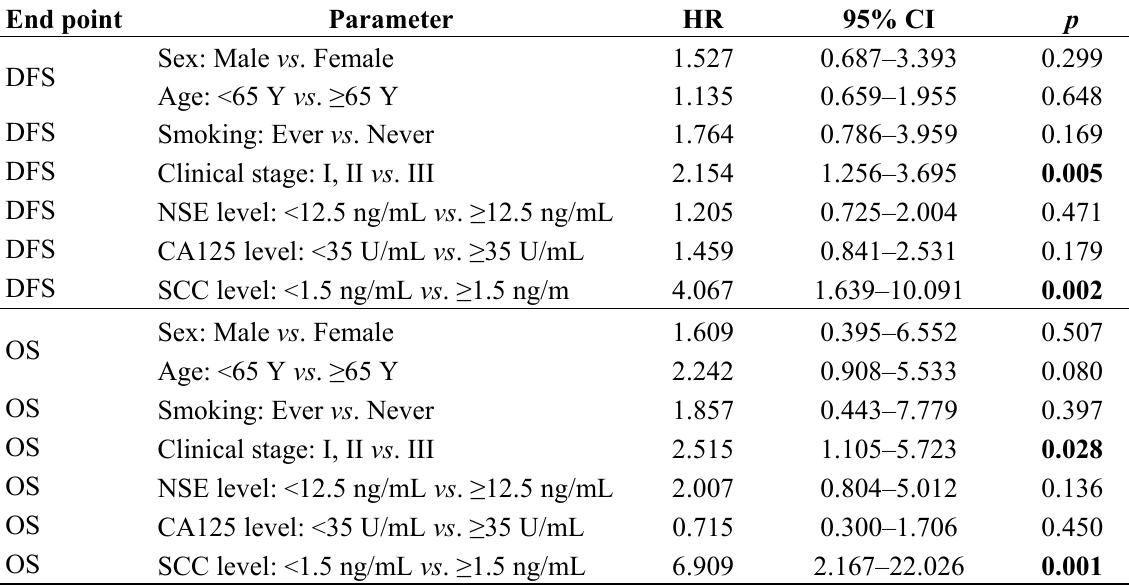
Table 3. Multivariate analysis for disease-free survival (DFS) and overall survival (OS) in squamous cell lung cancer.